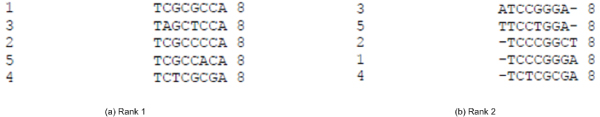
Edit distance cluster for bidirectional promoters. Sequence alignments corresponding to the word-based clusters of the top 2 overrepresented words of the bidirectional promoters. For each cluster, five words were chosen based on their overall overrepresentation in the promoter set. Rank 1 (a) is corresponding to the word TCGCGCCA, while Rank 2 (b) refers to TCCCGGGA.